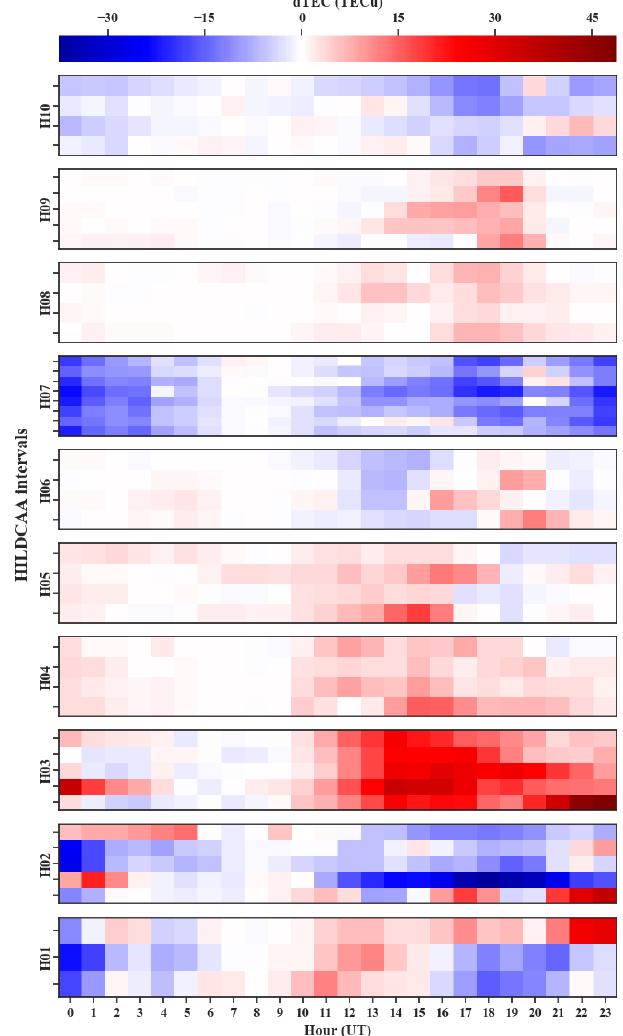
Figure 3. dTEC hourly values for all HILDCAA intervals at Ca- choeira Paulista (low-latitude station).